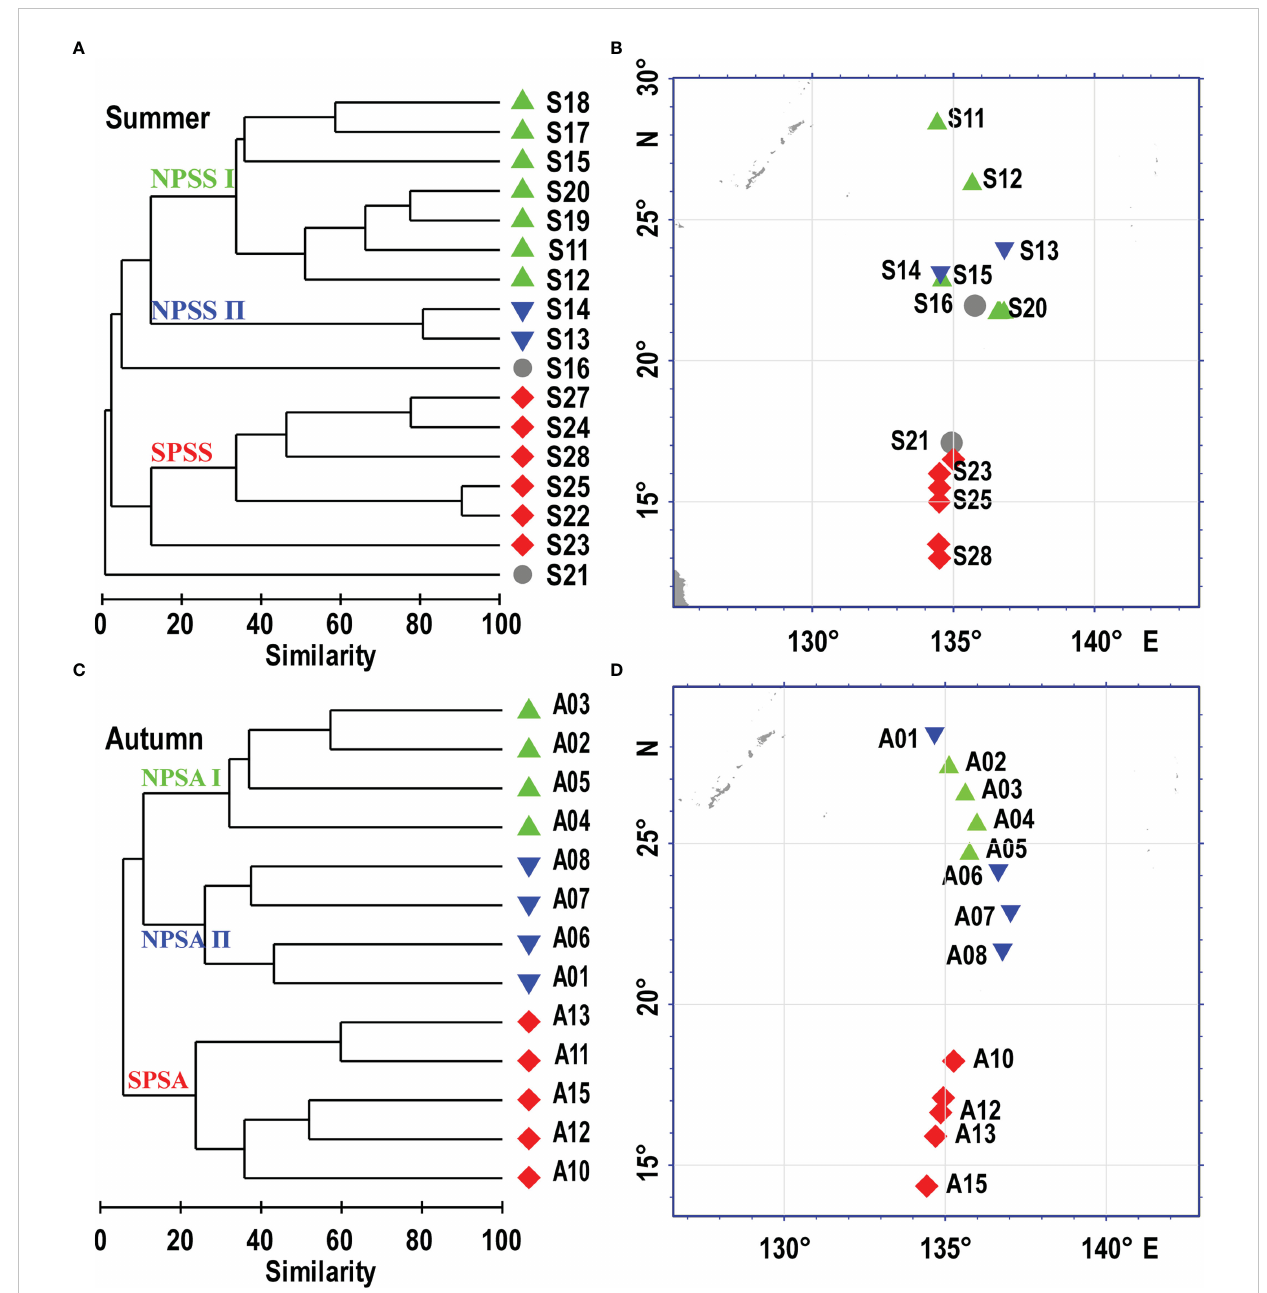
FIGURE 6 Dendrograms showing the stations groups de fi ned by the Bray-Curits similarity and their spatial locations in the Philippine Sea during the summer (A, B) and autumn (C, D) . NPSS (northern of the Philippine Sea in the summer), SPSS (southern of the Philippine Sea in the summer), NPSA (northern of the Philippine Sea in the autumn), SPSA (southern of the Philippine Sea in the